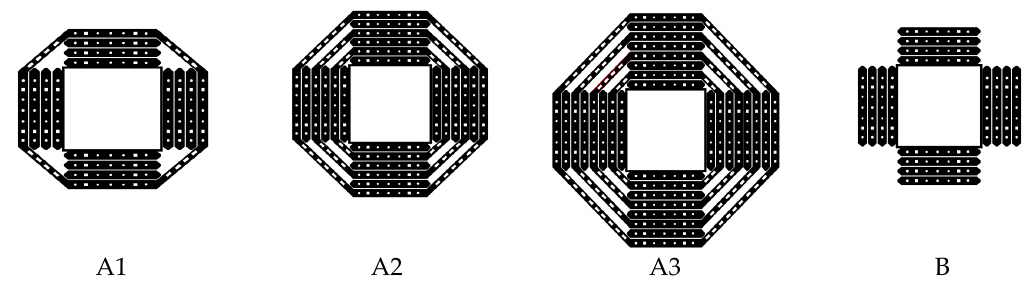
Figure 1. Carbon fiber reinforced polymer (CFRP) pattern A with diagonal strips provide higher two-way shear capacity compared to pattern B with orthogonal strips [25].